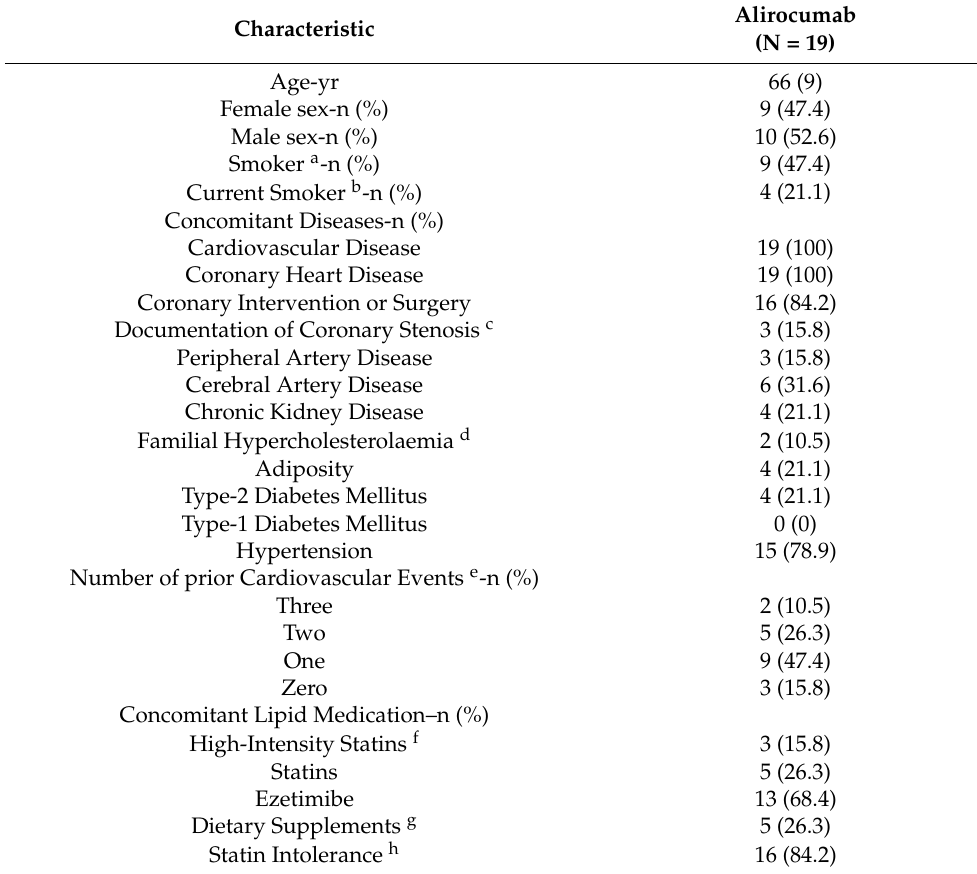
Table 2. Characteristics of Trial Participants (Trial